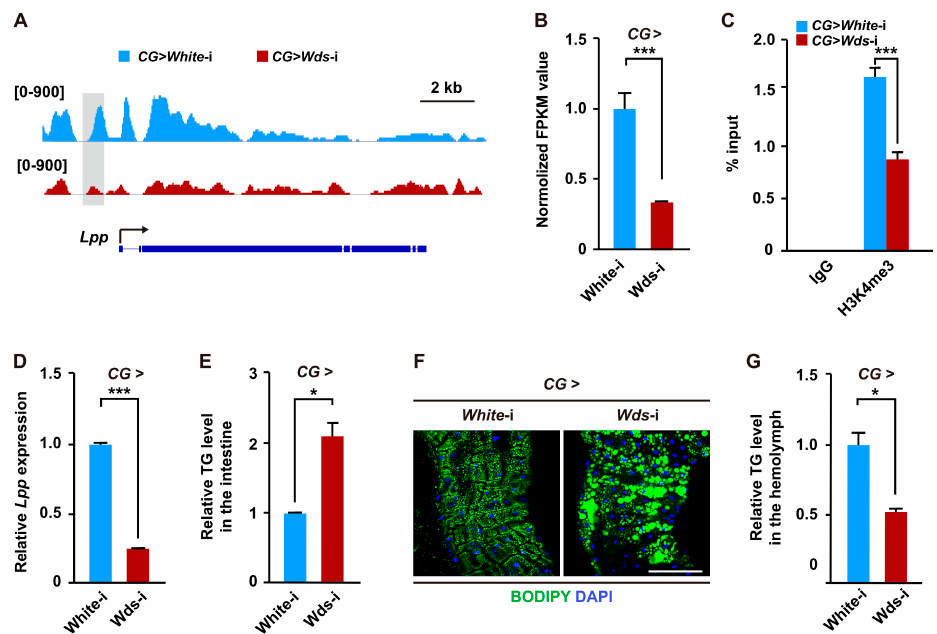
Figure 3. Fat body-specific knockdown of Wds downregulated Lpp transcription and impaired lipid transport. ( A ) Fat body-specific Wds knockdown-caused changes in H3K4me3 ChIP peaks within the promoter of the Lpp gene that encodes a lipoprotein mediating lipid transport from the intestine and was also included in the depDEGs. The representative peak was highlighted in grey. The arrow indicated transcription direction. ( B ) RNA-seq data of Wds knockdown-induced decrease in Lpp mRNA expression in the larval fat body. FPKM, fragments per kilo base of transcript per million mapped fragments. ( C ) ChIP-qPCR con fi rmation of fat body-speci fi c Wds knockdown-caused decrease in H3K4me3 enrichment within the Lpp gene in the fat body of Drosophila third instar larvae. ( D ) Wds knockdown in the fat body downregulated Lpp transcription in the fat body (n = 3, 10 larvae per group). ( E , F ) Fat body-speci fi c Wds knockdown caused elevated TG levels (n = 3, 20 larvae per group) ( E ) and lipid accumulation ( F ) in the third instar larvae intestine but decreased TG levels (n = 3, 60 larvae per group) in the hemolymph ( G ). BODIPY, green; DAPI, blue. Scale bar, 100 µm. Data are presented as the mean ± SE (error bars). For the signi fi cance: * p < 0.05 and *** p < 0.001 versus the control.